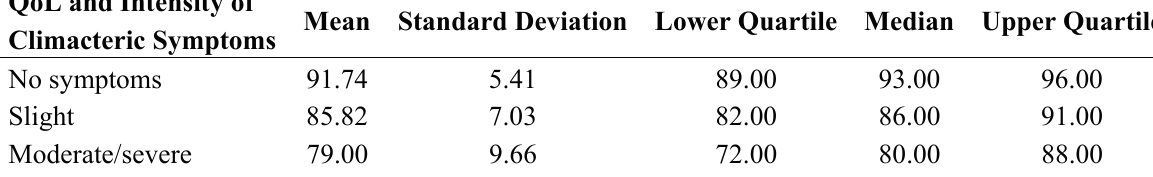
Table 3. Reported quality of life broken down by symptom intensity and socio-demographic data. QoL and Intensity of Climacteric